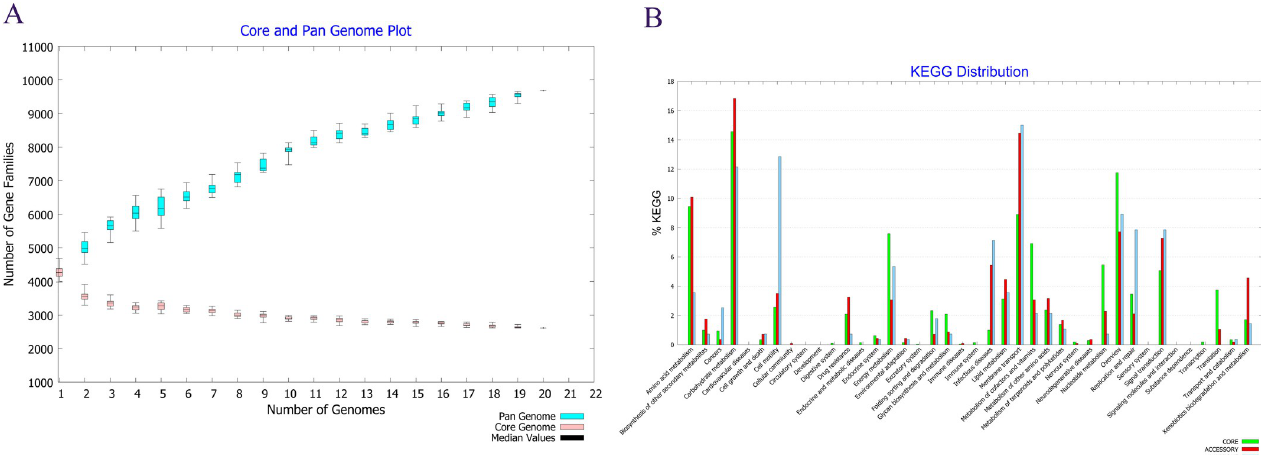
Fig 2. A. The distribution of pan/core gene families of 20 clinical Enterobacter species. The pan/core gene profiling of ECC strains indicated that the number of pan gene families differs meaningfully among the strains. While, the distribution of core gene families was almost close. B. The functional classification of core, accessory and unique genes among 20 clinical Enterobacter species. The orthologous core, accessory and unique genes were clustered in 19 known functional classes and one unknown class.